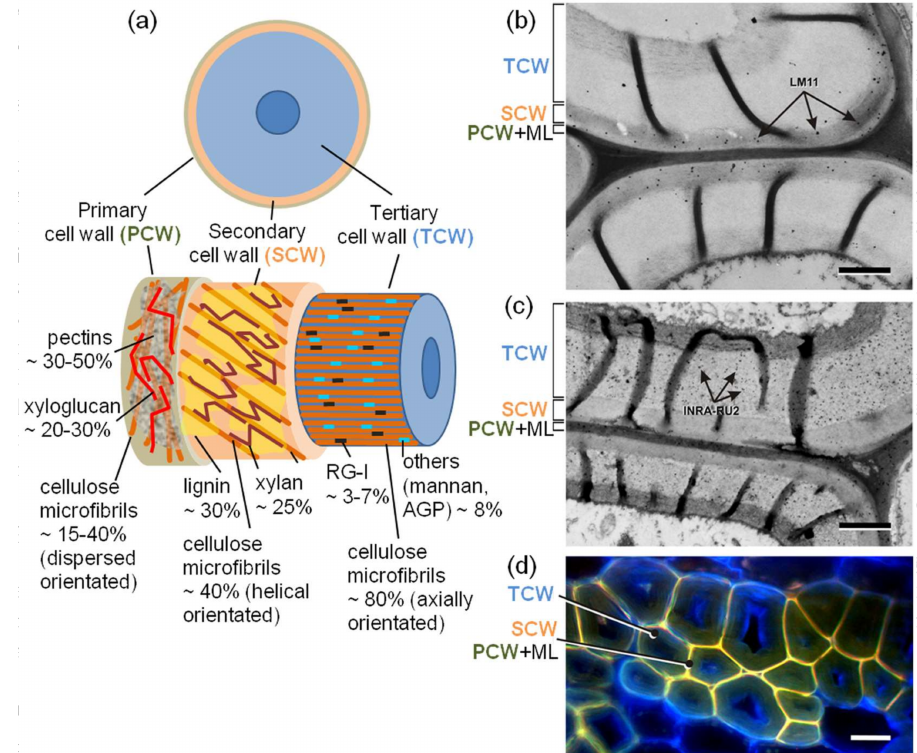
Figure 3. Scheme of structure and composition of different layers of bast fiber cell wall. ( a ) Scheme of organization and composition of different layers of fiber cell wall; ( b , c ) immunolocalization of cell wall polysaccharides with ( b ) LM11 antibody (specific to β -1,4-xylan; [30]) and ( c ) INRA-RU2 antibody (specific to RG-I backbone; [31]) in hemp stem secondary fibers (photographs by V. Salnikov KIBB KSC RAS); bar 1 µ m. Secondary cell wall layer of bast fibers was effectively labeled with LM11 antibody, tertiary cell wall layers of bast fibers, on the contrary, did not bind LM11 antibody, but were labelled by INRA-RU2 antibody. ( d ) Cross-section of primary phloem fiber bundles of hemp stem; stained with CalcofluorWhite; under UV light (lignified cell wall layers look yellow due to lignin autofluorescence, non-lignified tertiary cell wall layers look blue); bar 20 µ m. ML—middle lamellae, AGP—arabinogalactan